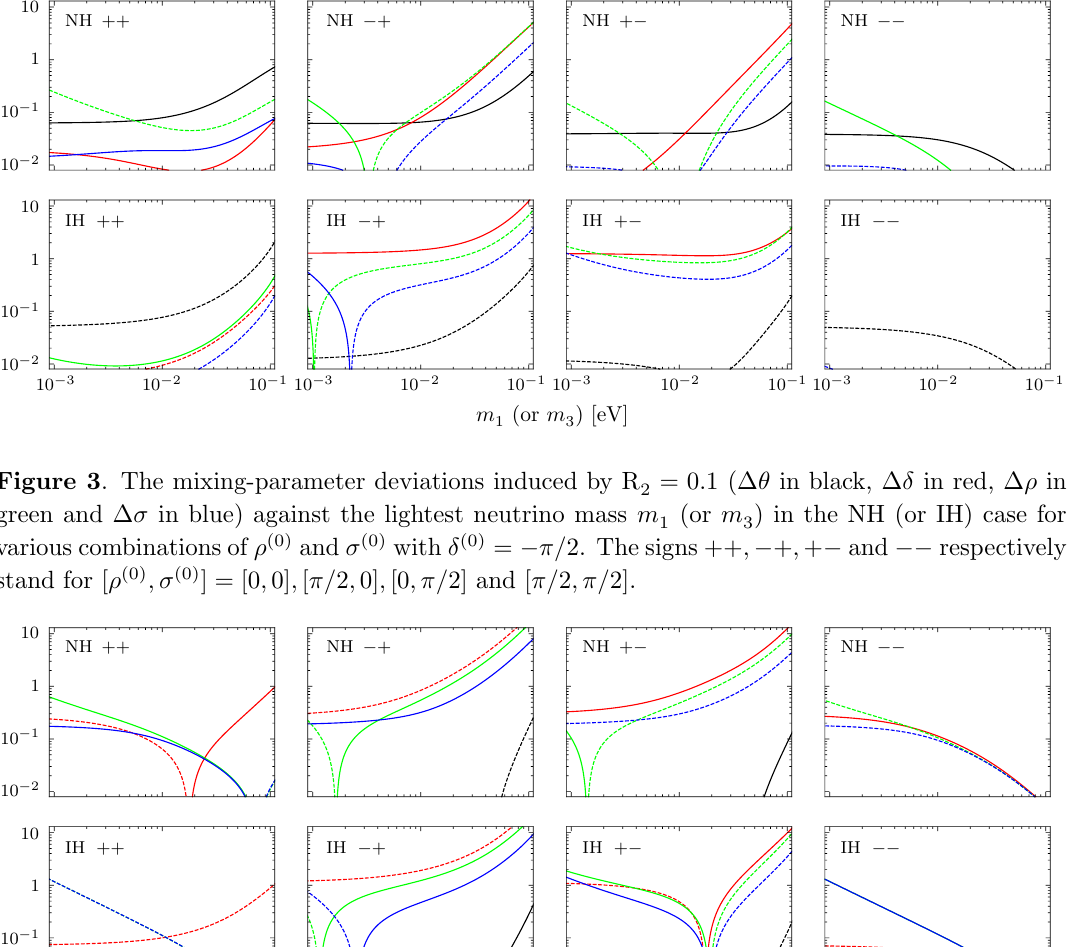
Figure 4 . The mixing-parameter deviations induced by I green and (cid:1) (cid:27) in blue) against the lightest neutrino mass m various combinations of (cid:26) (0) and (cid:27) (0) with (cid:14) (0) = (cid:0) (cid:25)= 2. The signs ++ ; (cid:0) + ; + (cid:0) and (cid:0)(cid:0) respectively stand for [ (cid:26) (0) ; (cid:27) (0) ] = [0 ; 0] ; [ (cid:25)= 2 ; 0] ; [0 ; (cid:25)= 2] and [ (cid:25)= 2 ; (cid:25)=